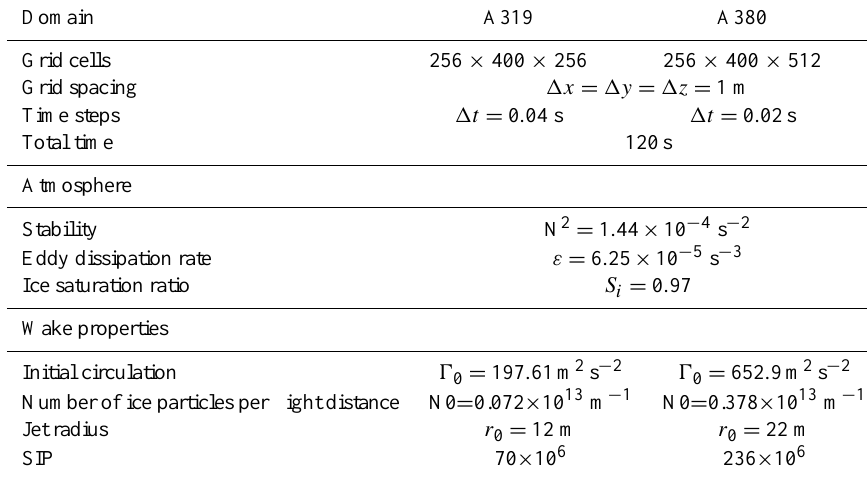
Table 3. Initialization and settings of the EULAG-LCM model for the contrail